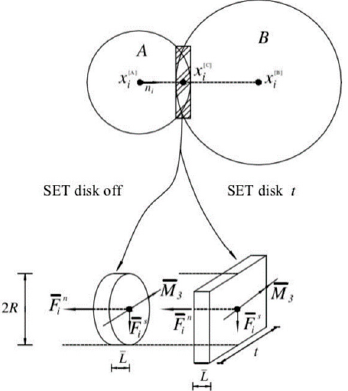
Figure 6. Schematic diagram of linear parallel bond model between particles.